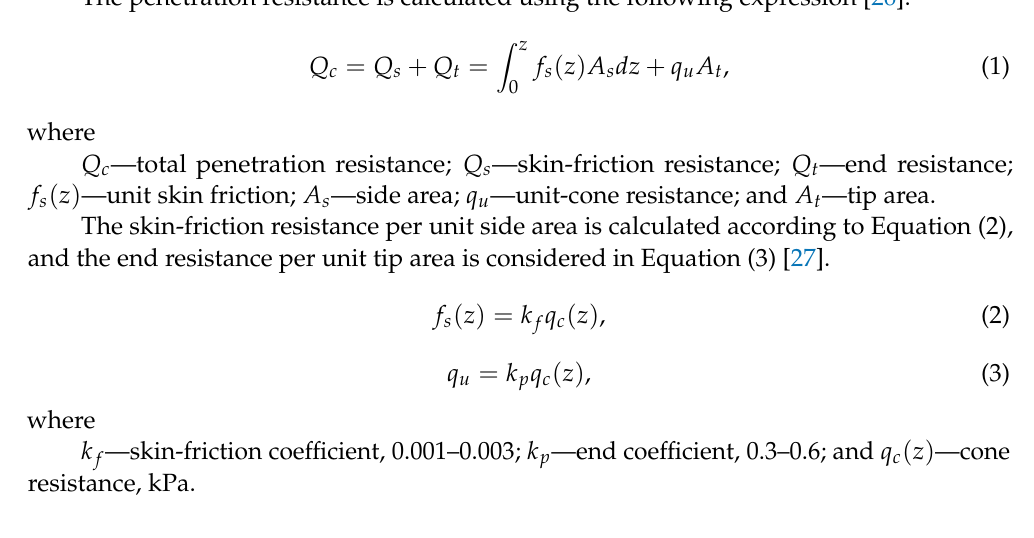
BB25 model were 1.86 and 0.93, respectively. The values of the HB30 model were